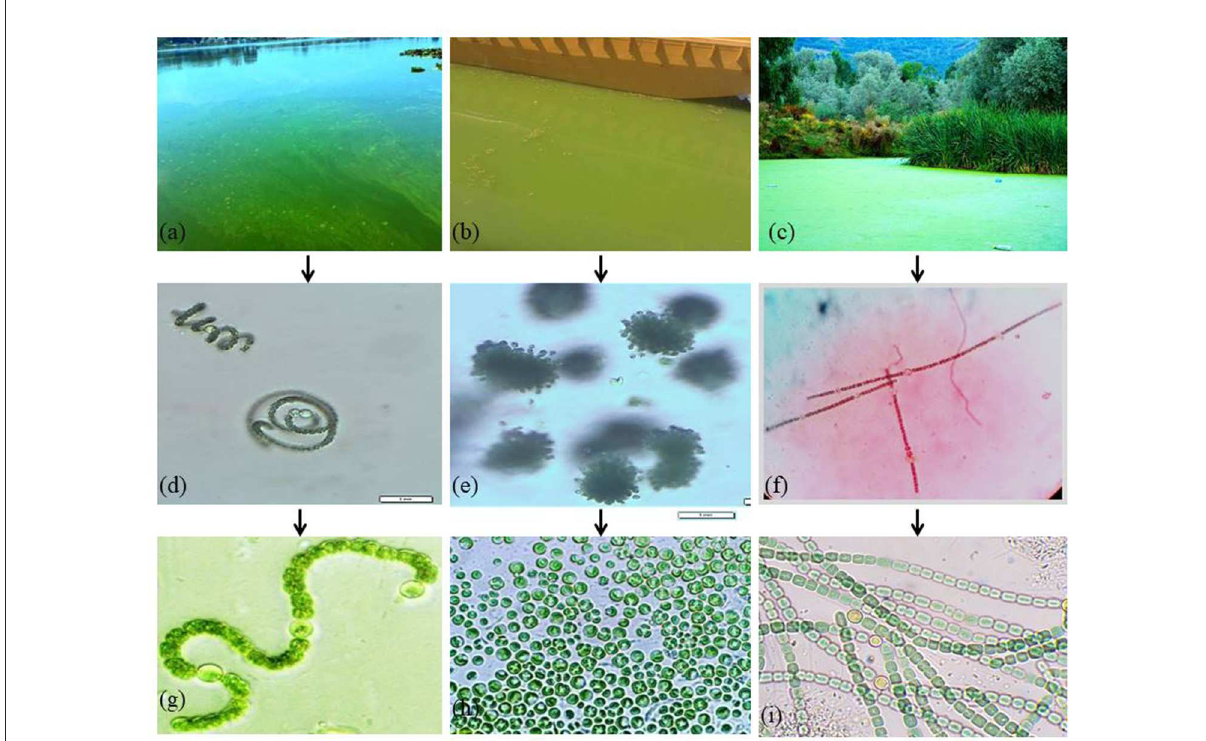
FIGURE2 Cyanobacterial blooms at Dal Lake: (a) Grand Palace Gath (Site 1) (b) Nigeen basin (Site 2) and (c) Gagribal basin (Site 3). (d–f) Microscopic examination of dominant cyanobacterial species in natural bloom samples. Photos of isolated cyanobacterial strains: (g) Dolichospermum sp. strain AE02 (h) Microcystis sp. strain AE03, and (i) Dolichospermum sp. strain